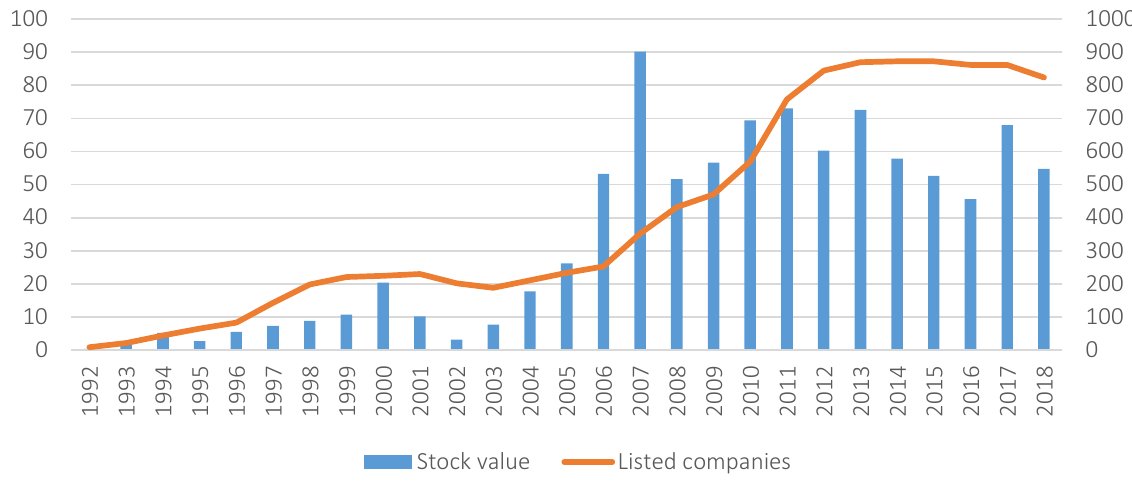
Figure 2. Stocks traded value and number of listed companies on WSE in 1992–2018